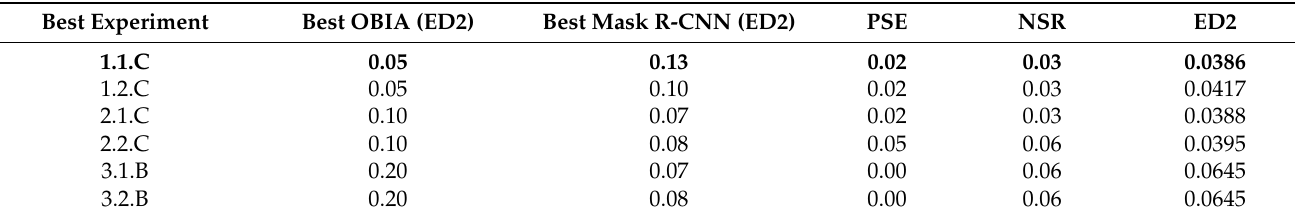
Table 4. Segmentation accuracies of the fusion of Object-Based Image Analysis (OBIA) and Mask Region-based Convo- lutional Neural Networks (Mask R-CNN). PSE: Potential Segmentation Error; NSR: Number Segmentation Ratio; ED2: Euclidean Distance v.2. In bold the most accurate